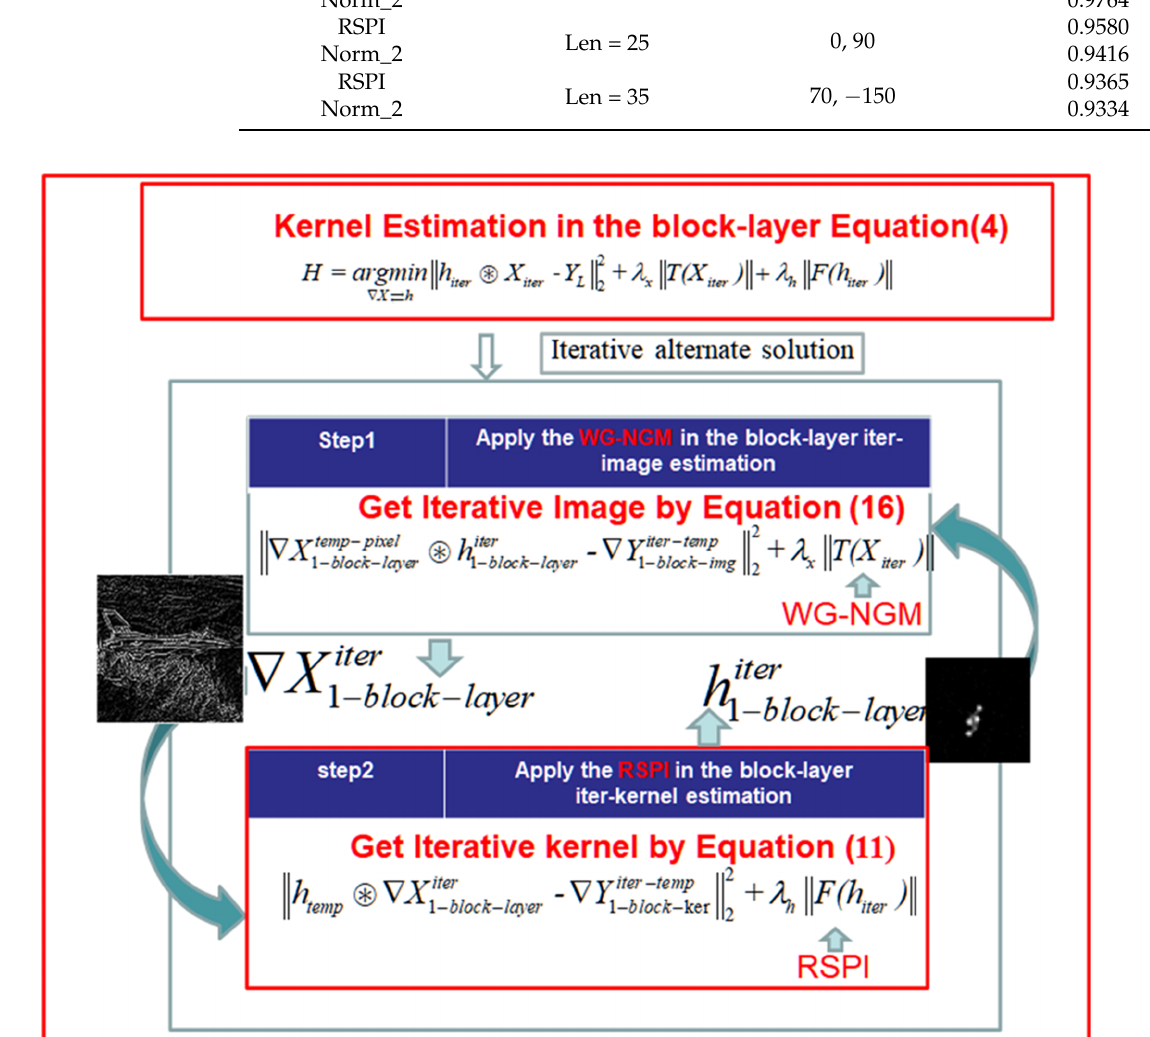
Figure 2. The block layer kernel estimation flow chart. According to the EM algorithm idea, iterative kernels are estimated alternatively with the iterative image, which needs to be fixed in the iterative image when estimating the kernel and vice versa. Table 1. Example of the method with RSPI.